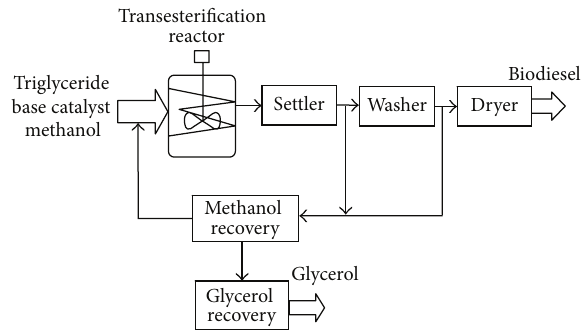
Figure 1: Biodiesel production by